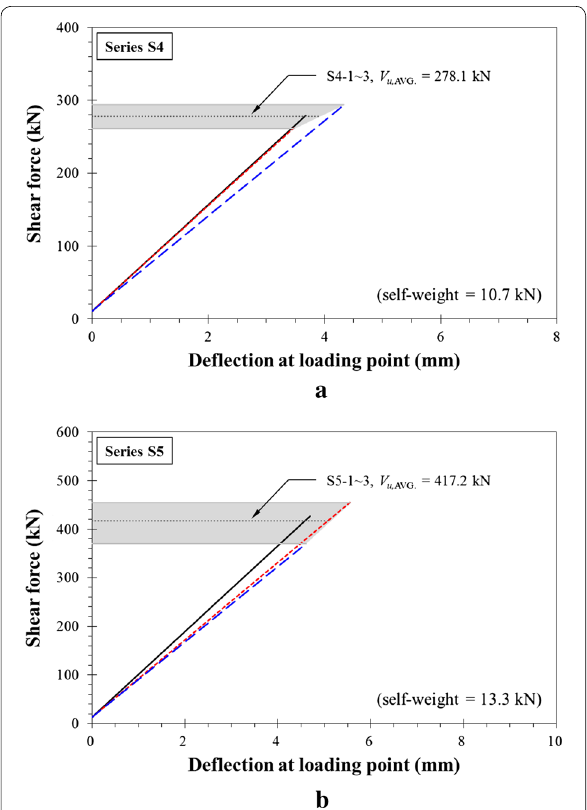
Fig. 8 Load‑displacement reponses of specimens series S2 and S2.65. a Specimens series S2, b specimens series S2.65.